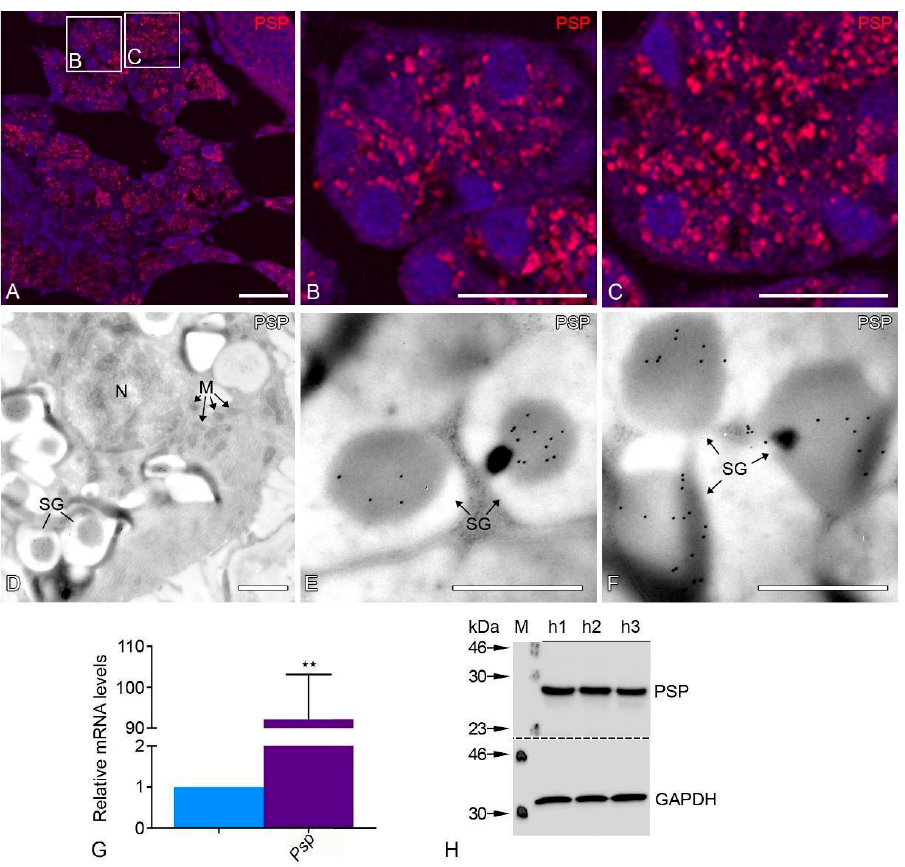
Figure 1. PSP staining is used to identify human parotid gland tissue. Human parotid gland im- munofluorescence labeling for PSP in certain areas ( A ) and higher magnification PSP staining in human acini ( B ) and human striated ducts ( C ). Ultrastructural immunocytochemical localization of PSP staining in secretory granules of the human parotid gland ( D ) using the ultra-small gold (10 nm) method on LR White sections with post-embedding protein immunocytochemistry. Higher magnifi- cation view of a region containing PSP positive secretory granules of human acini ( E , F ). N = nucleus, M = mitochondria, SG = secretory granules. Bars represent: 50 µ m ( A ); 10 µ m ( B , C ); 5 µ m ( D ) 2 µ m ( E , F ). qRT-PCR analyses on human parotid tissues showing mRNA levels encoding for parotid specific protein (violet bar) compared to Gapdh (blue bar) as a housekeeping gene (** p < 0.0011) ( G ). PSP and GAPDH were probed on Western blots using an affinity-purified antibody ( H